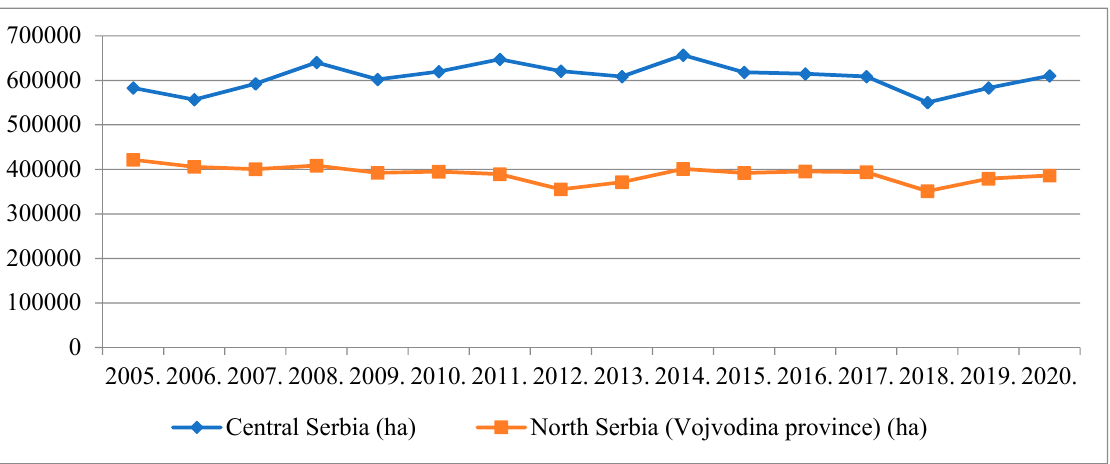
Figure 10. Area of cultivation maize crops in Republic Serbia during the period 2005–2020 .